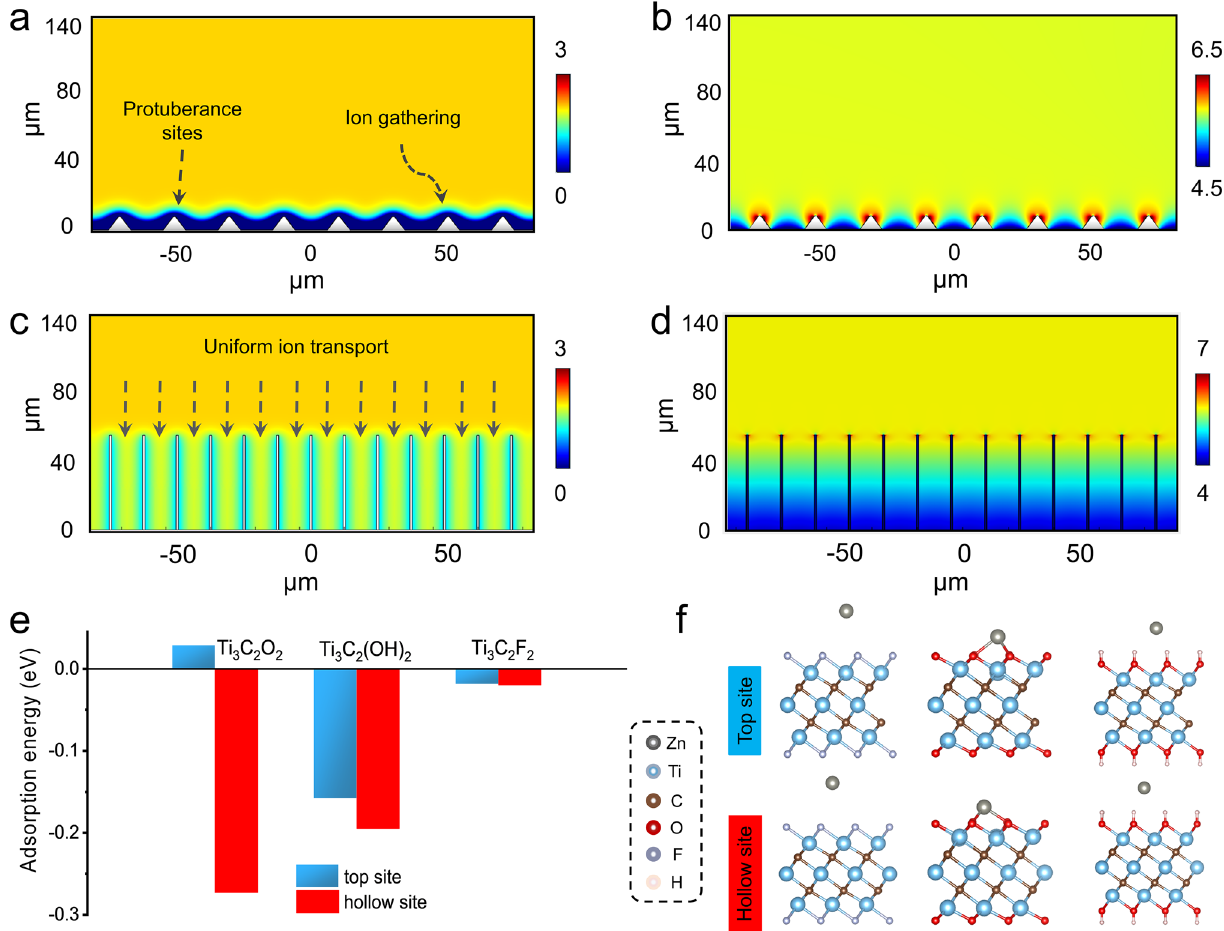
Fig. 4 Transient simulation results of zinc ions concentration distribution and electrolyte current density in the a–b pure Zn, and c–d 3D MXene array@Zn anode at the current density of 0.5 mA cm −2 . e DFT calculation of the absorption energy between single zinc atom and differ- ent terminal groups (–F, –O and –OH)-decorated Ti 3 C 2 T x MXene at the hollow and top site, and f corresponding side-view